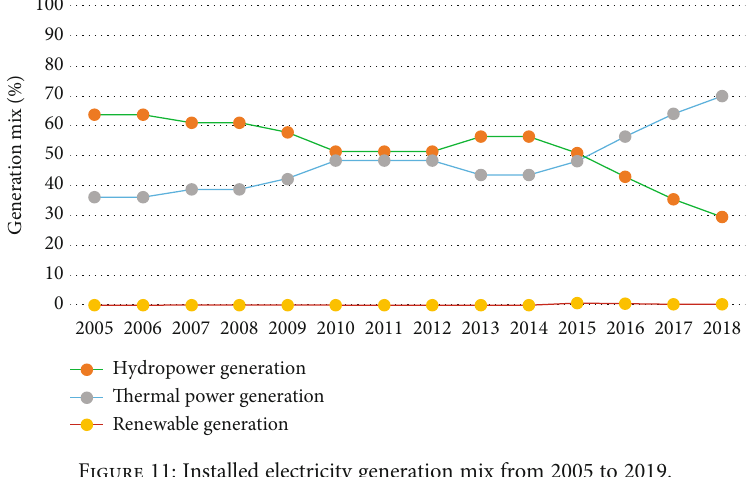
Figure 11: Installed electricity generation mix from 2005 to